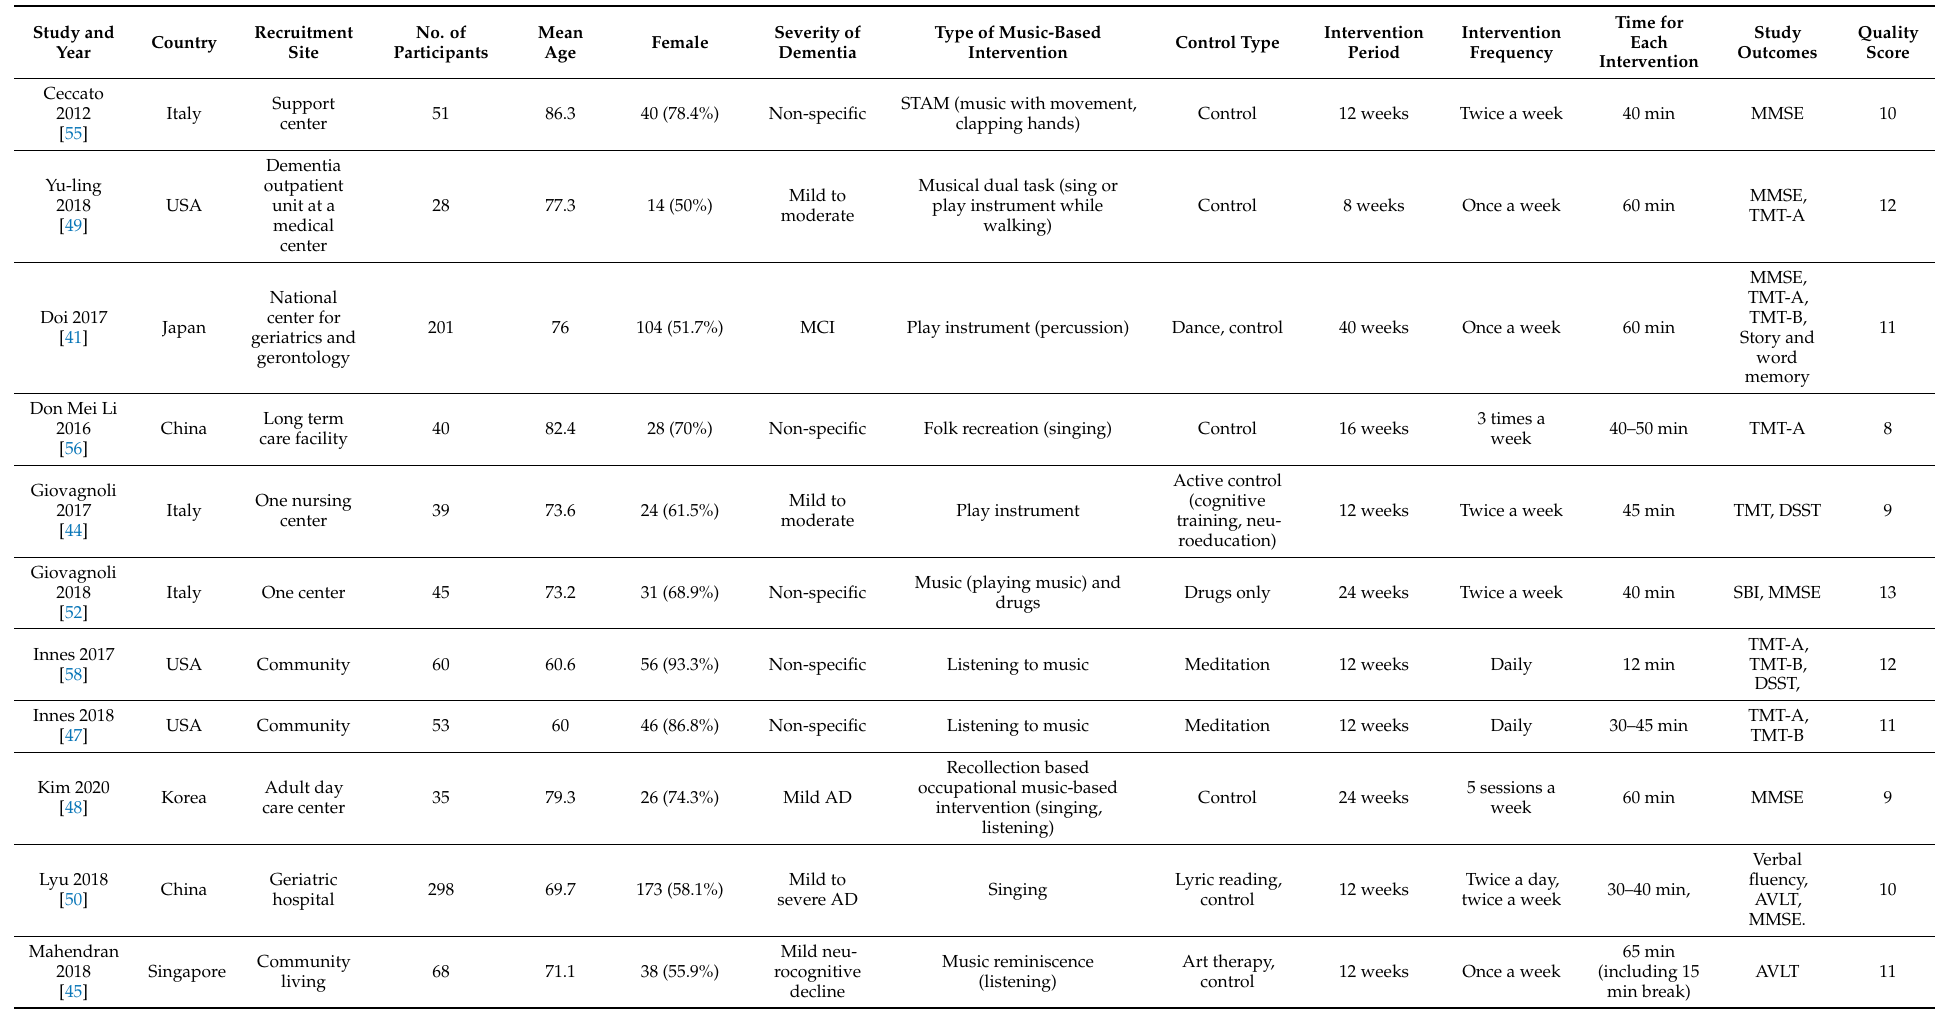
Table 1. Characteristics of included randomized controlled